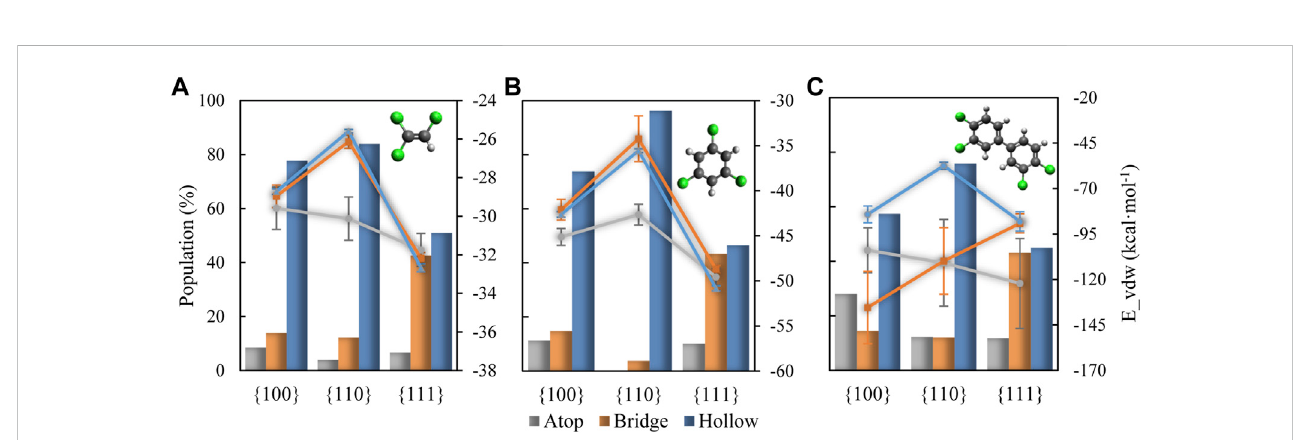
FIGURE 10 Proportion of adsorbed molecules adsorbed on the different sites for (A) TCE at 230 K, (B) TCB at 360 K and (C) PCB77 at 500 K shown in bar chart and with left vertical axis. Corresponding binding energy values are shown in solid lines and with right vertical axis.